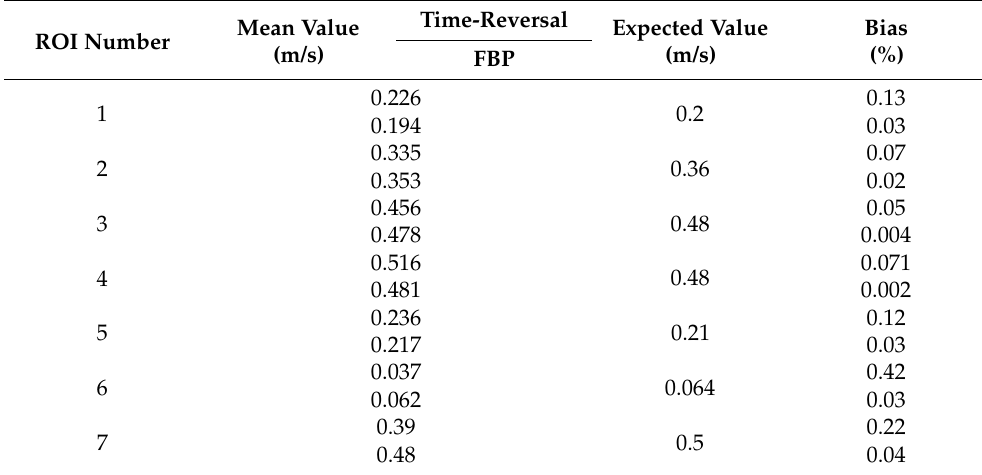
Table 3. Mean values, expected values, and bias at the ROIs shown in Figure 9 for attenuation coefficient